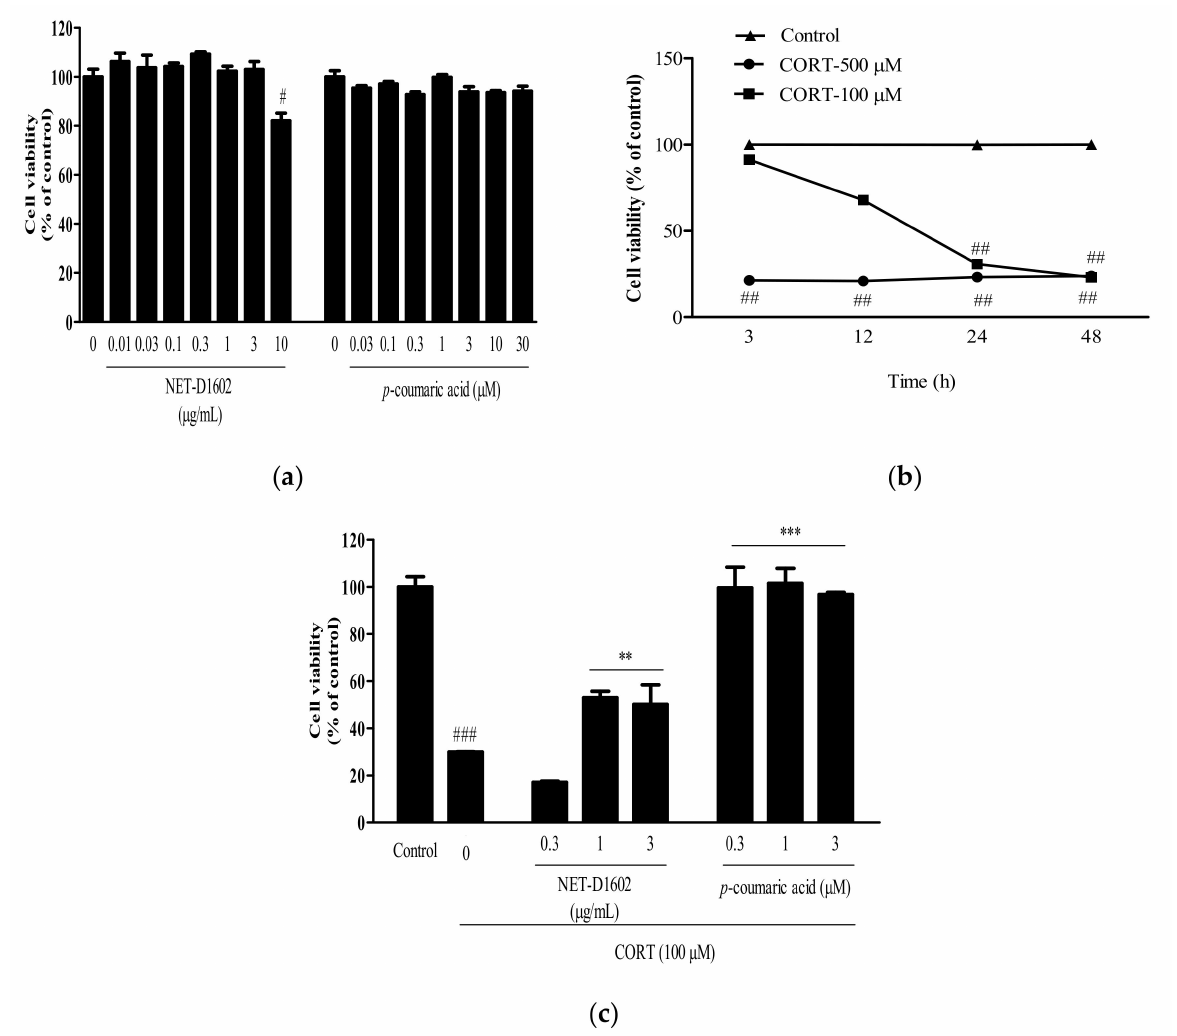
Figure 3. Effects of NET-D1602 and p -coumaric acid on the viability of CORT-induced primary cultured rat cortical neurons. ( a ) Treatment with various concentrations of NET-D1602 and p -coumaric acid for 24 h. ( b ) Time course of cell viability after CORT treatment (100 and 500 µ M). ( c ) Pretreatment with NET-D1602 (0.3, 1, and 3 µ g/mL) and p -coumaric acid (0.3, 1, and 3 µ M) for 6 h and subsequent treatment with CORT (100 µ M) for 24 h in the absence or presence of NET-D1602 and p -coumaric acid. The values are expressed as the mean ± standard error of the mean ( n = 3). # p < 0.05, ## p < 0.01, and ### p < 0.001 compared to that of the untreated group; ** p < 0.01, and *** p < 0.001 compared to that of the CORT group. CORT, corticosterone; NET-D1602, HP-20 resin fraction of the water extract of Vaccinium bracteatum